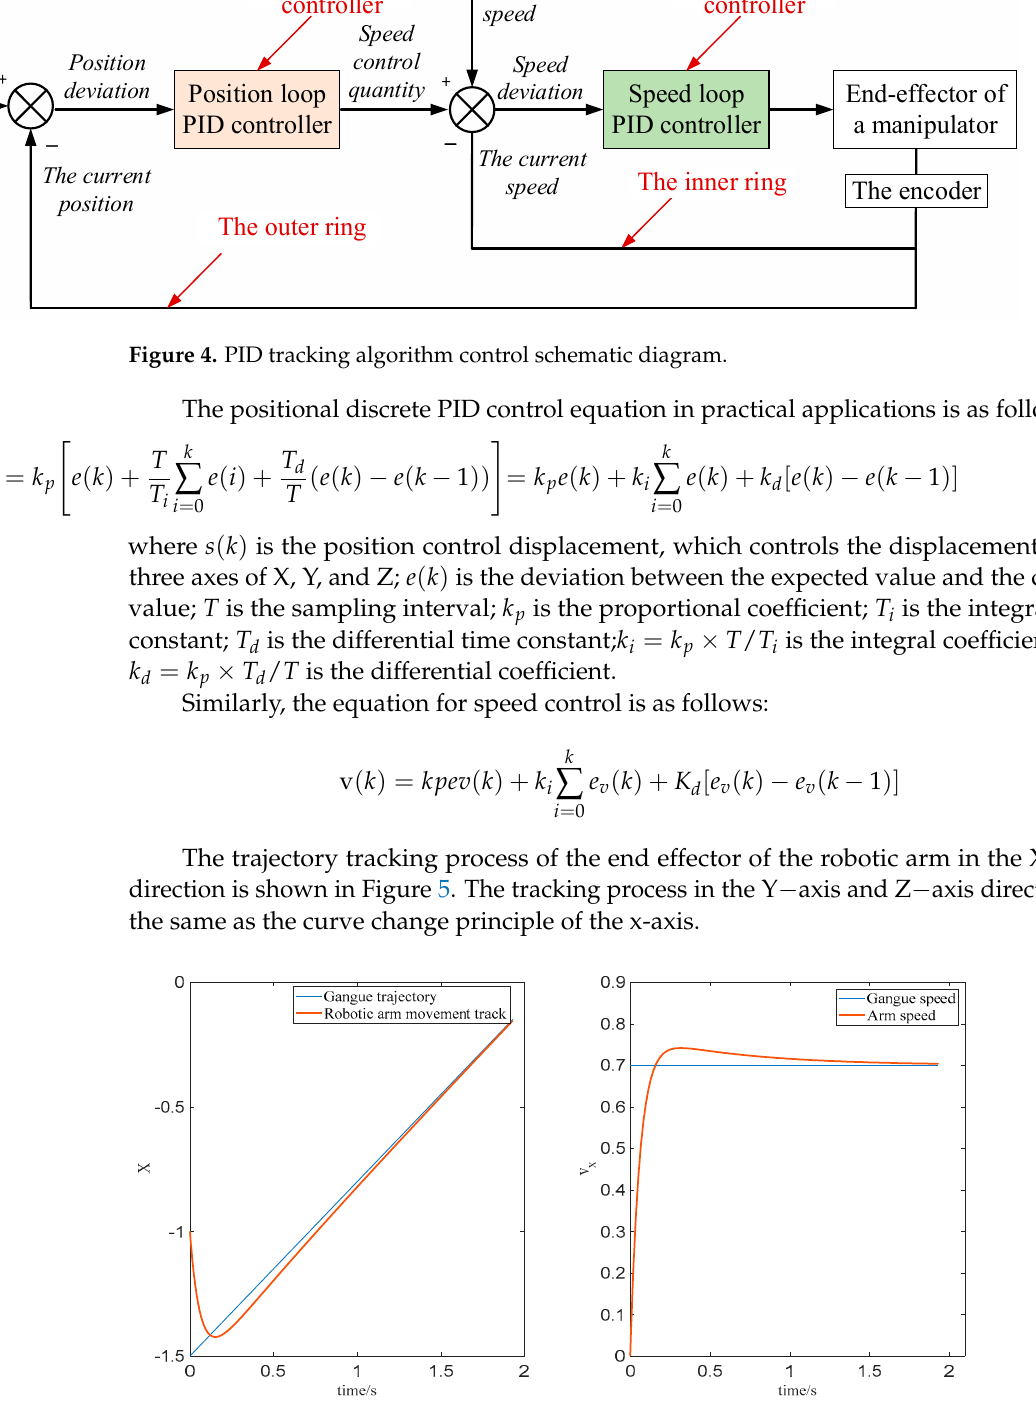
Figure 5. X − axis position and velocity change curve. R tracks the grasping time The robotic arm i t , Y − axis motion time X − axis motion time ix t arm; and defines ij